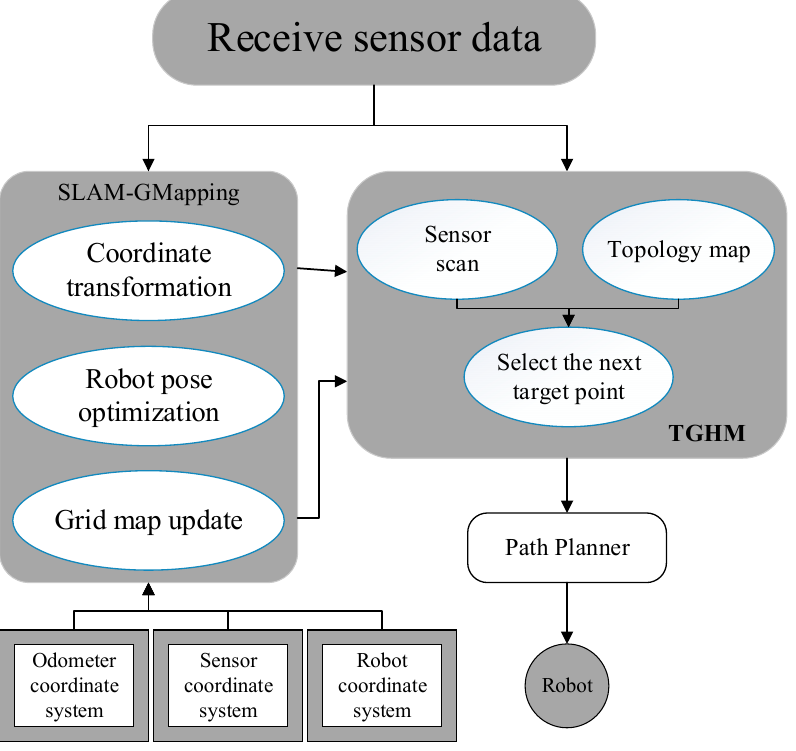
Figure 6. The modular structure of exploration.